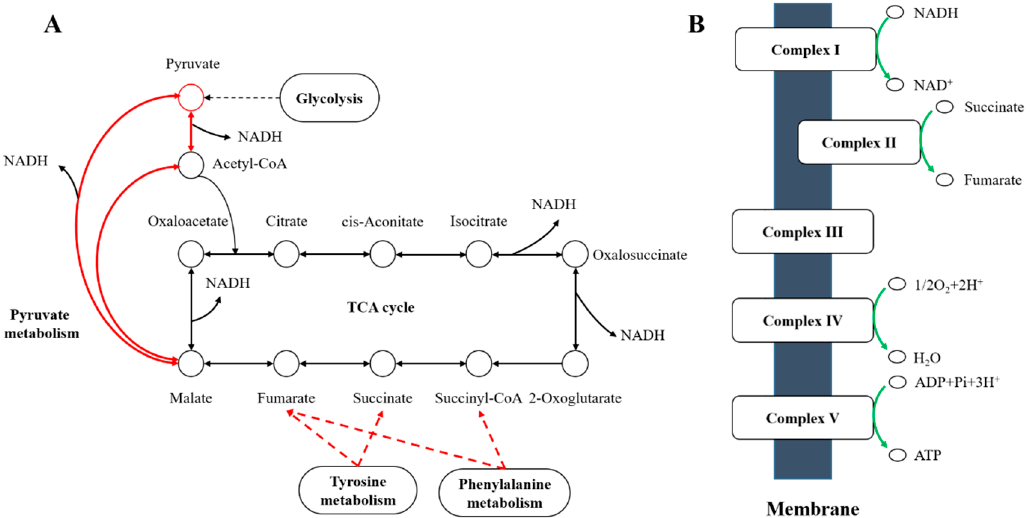
Figure 6. Sketch map of the effects of C. elegans extracts on the metabolism of A. pascens ZZ21. ( A ) Red arrows indicate metabolic processes promoted by the extract treatment, such as pyruvate metabolism, the citrate cycle (TCA cycle), and tyrosine and phenylalanine metabolism. ( B ) Green arrows indicate metabolic processes suppressed by the treatment, such as oxidative phosphorylation.